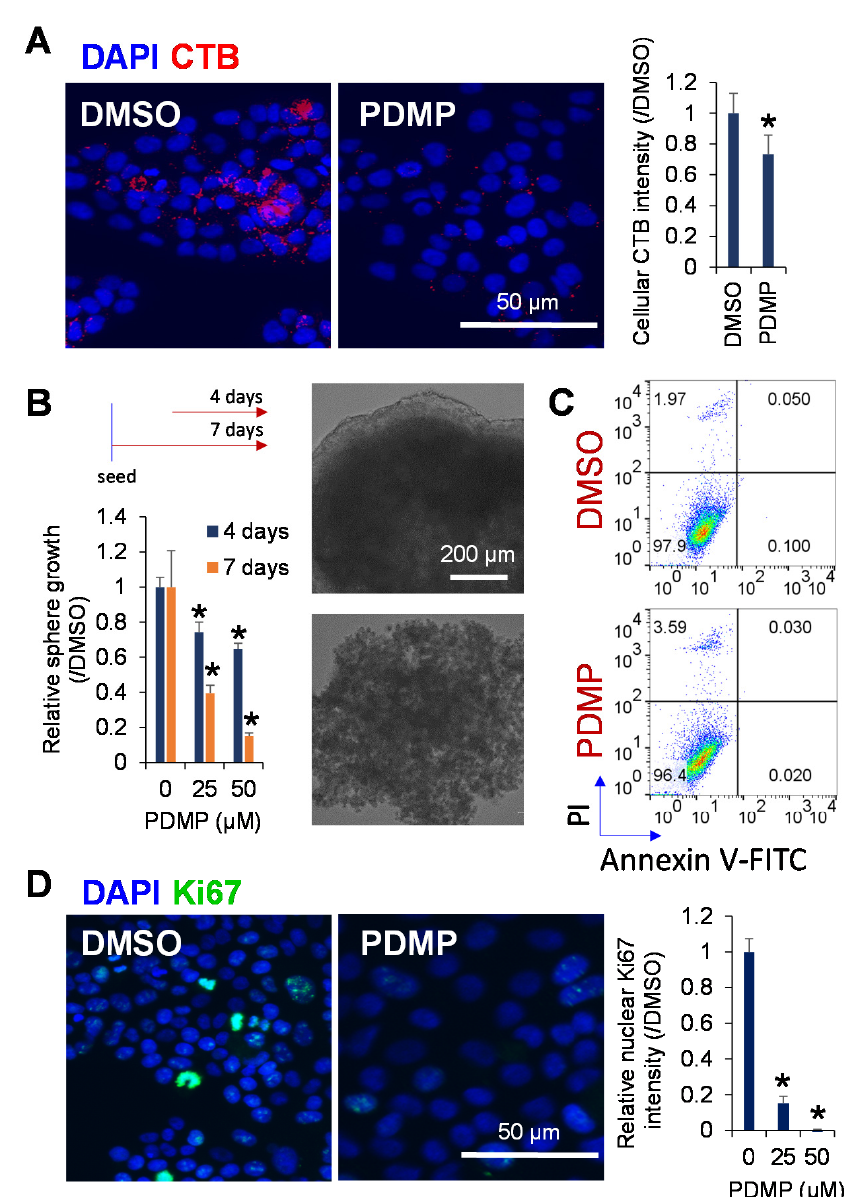
Figure 3. Inhibition of ganglioside synthesis suppressed spheroid proliferation of liver cancer cells. ( A ) Immunofluorescence staining of GM1 probe CTB (red) in the HCC cell line, JHH7, treated with vehicle control DMSO or ganglioside synthesis inhibitor PDMP at 50 µ M for 2 h (left), and the relative fluorescent intensity of CTB (right). Scale bar, 50 µ m. ( B ) Sphere proliferation of JHH7 cells treated with vehicle control DMSO or ganglioside synthesis inhibitor PDMP at indicated doses for 4 days or 7 days (left), and representative microscopic images of JHH7 cells grown in sphere cultures treated with vehicle control DMSO or ganglioside synthesis inhibitor PDMP at 50 µ M for 7 days. Scale bar, 200 µ m. ( C ) Apoptotic cell death of JHH7 cells grown in monolayer cultures treated with vehicle control DMSO or ganglioside synthesis inhibitor PDMP at 25 µ M for 24 h was detected by dual staining with Annexin V-FITC and propidium iodide (PI) followed by flow cytometric analysis. ( D ) Immunofluorescence staining of cell proliferation marker Ki67 (green) in JHH7 cells grown in monolayer cultures treated with vehicle control DMSO or ganglioside synthesis inhibitor PDMP at 25 µ M for 24 h (left), and the relative fluorescent intensity of nuclear Ki67 (right). Nuclei were stained with DAPI (blue). Scale bar, 50 µ m. The data are presented as means ± SD. * p < 0.05 in Student’s t -test.